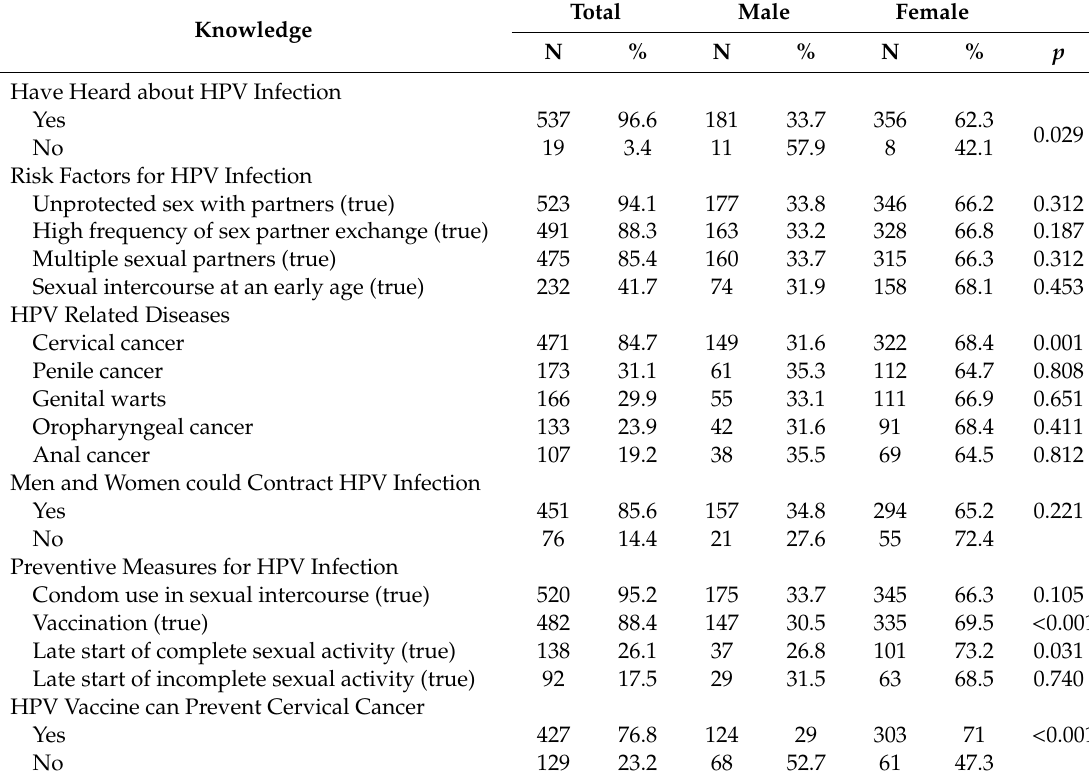
Table 2. Respondents’ knowledge of human Papilloma virus (HPV) infection and vaccination stratified for